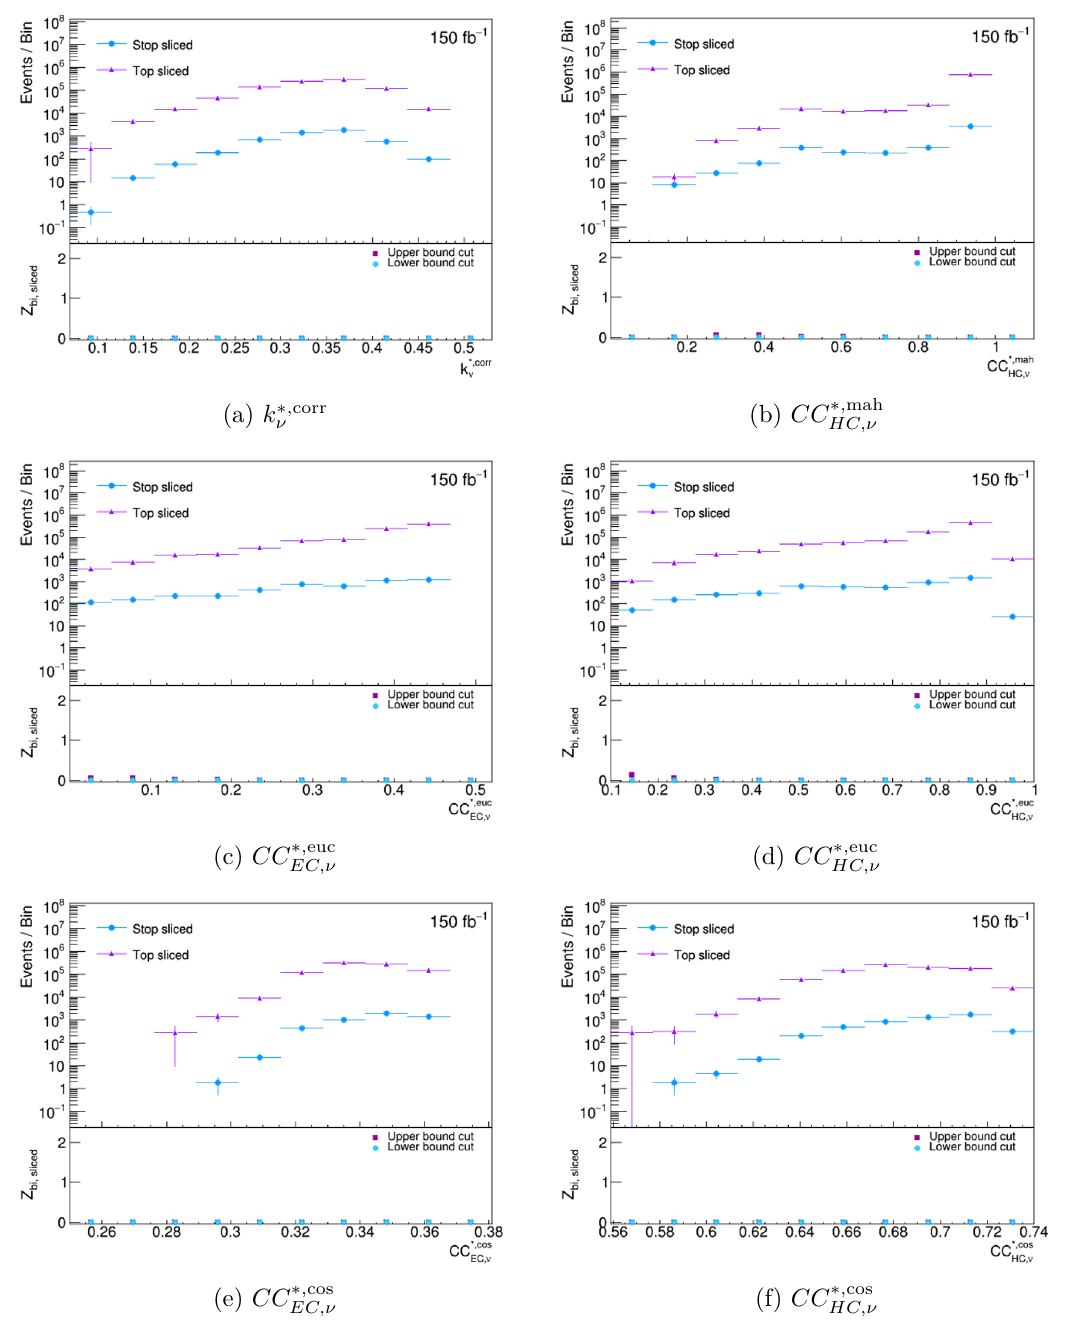
Figure 9. Event rates as functions of the network variables for the stop simplified model example. Events in the overflow bin are not shown in the distribution but are included in the Z bi